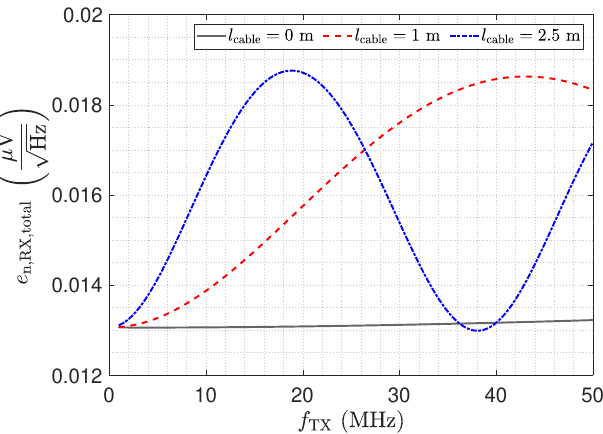
Figure 20. Total output voltage noise spectral density of the investigated matched input stage for three different transmission line lengths. The SPICE-based simulation includes the capacitive Π -network.